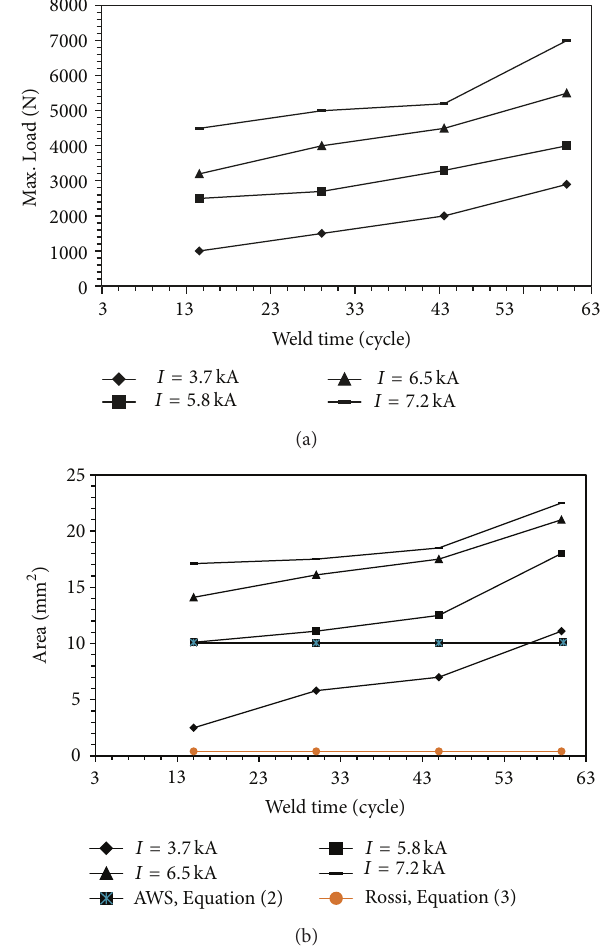
= 4 mm, 𝑡 = 0.8 mm; el